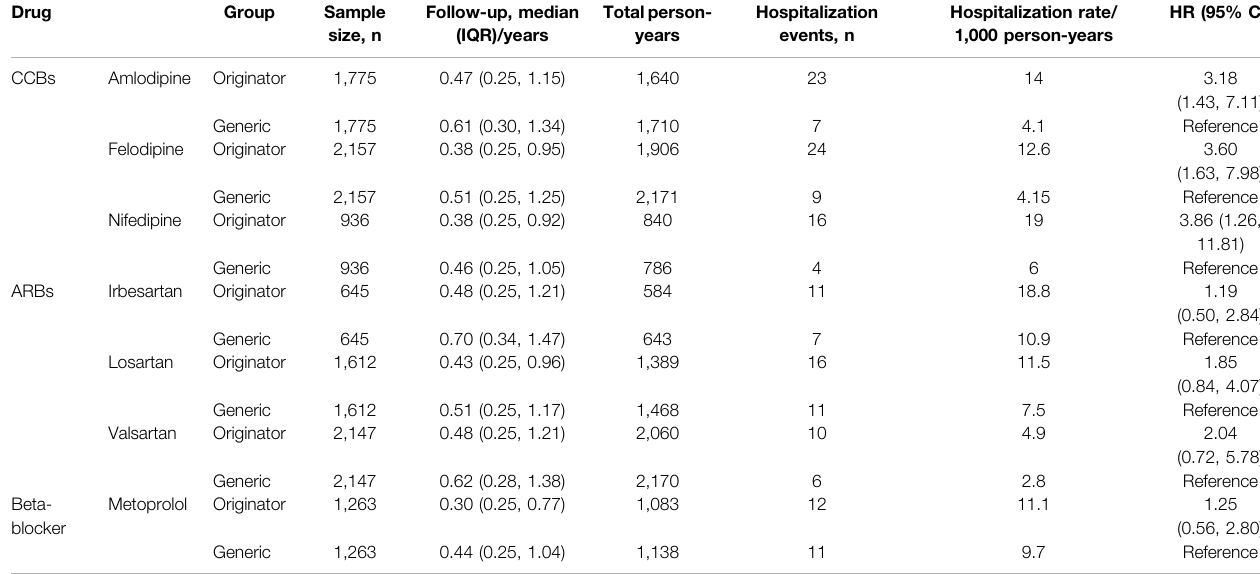
TABLE 1 | Hospitalization for hypertension-related CVD of originator vs . generic initiators after 1:1 propensity score matching. Drug